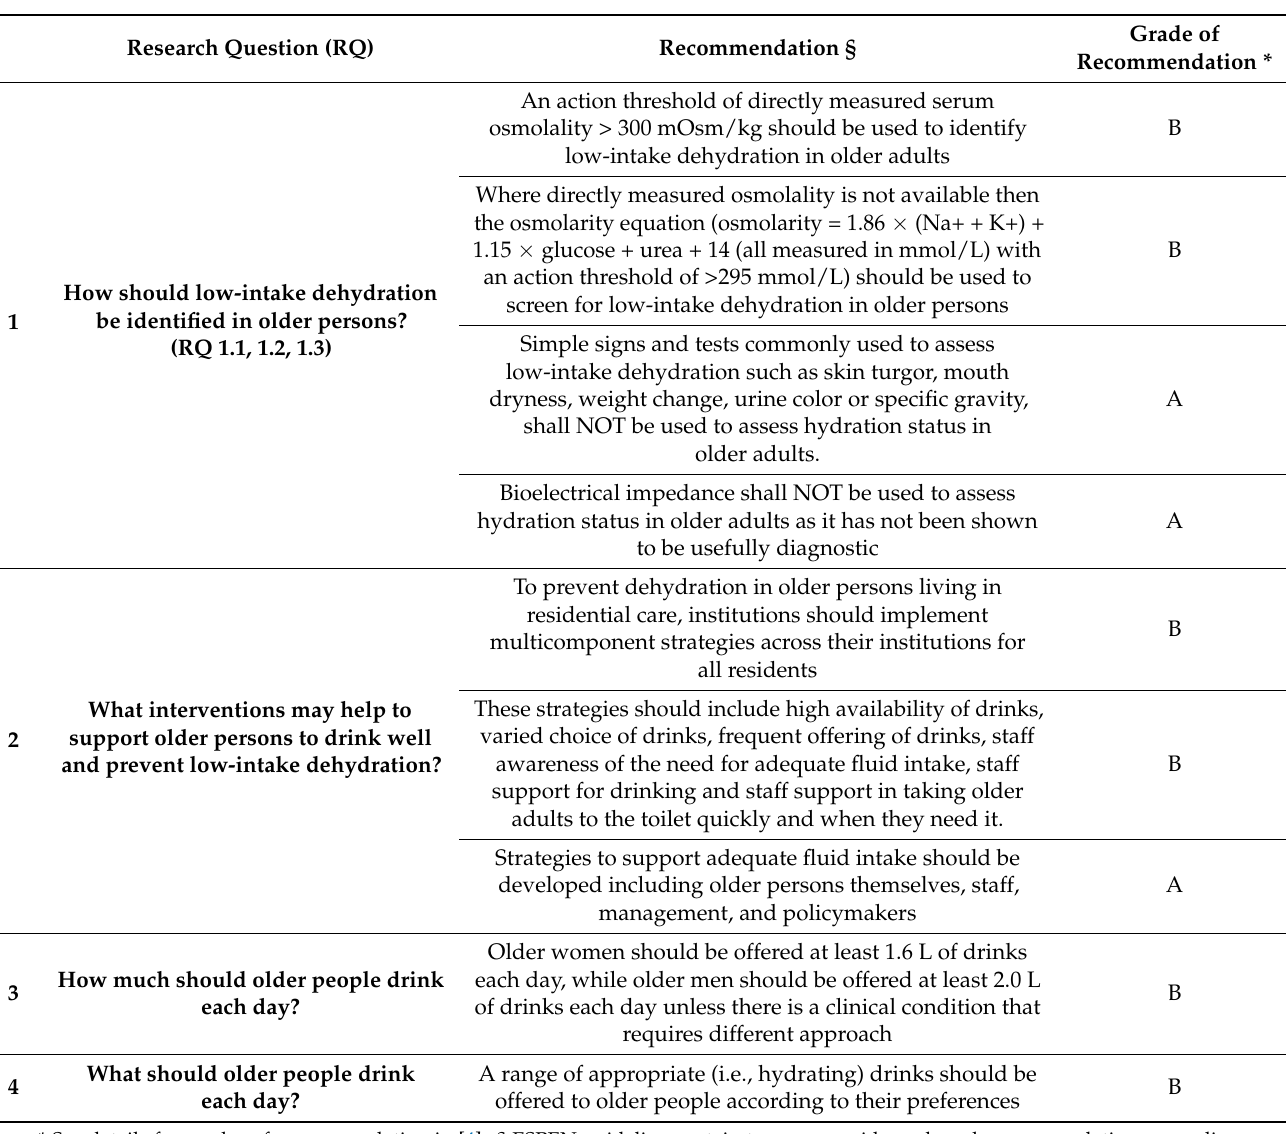
Table 1. Evidence-based recommendations regarding low-intake dehydration (adapted from [4])